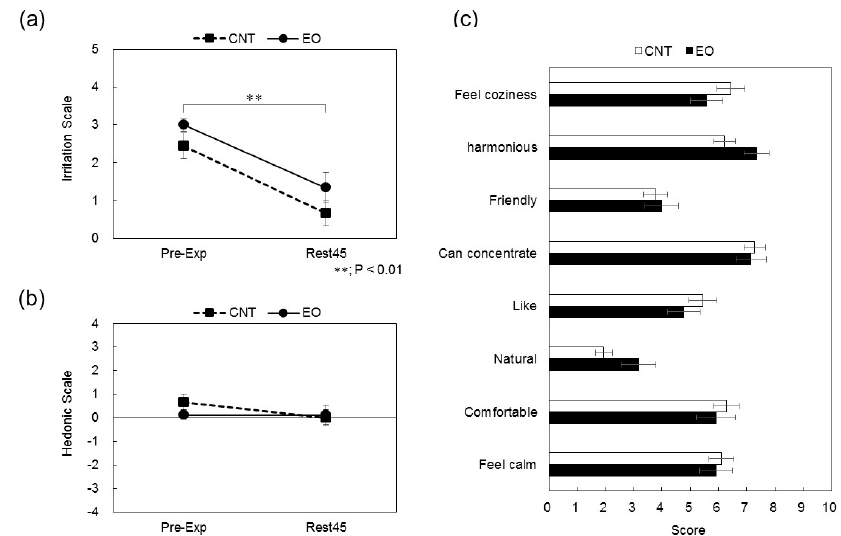
Figure 3. Subjective effects of the odor of the experiment room. ( a ) Irritation scores reported by participants in the control (square) and Japanese cedar wood essential oil (experimental; circle) conditions. CNT indicates the control condition, while EO indicates the experimental condition. Differences in pre-experiment and the end of experiment values were significant in both conditions ( p < 0.01). Data are shown as mean ± SEM; ( b ) Hedonic scores reported by participants in the control (square) and Japanese cedar wood essential oil (circle) conditions. No significant differences between conditions were observed. Data are shown as mean ± SEM; ( c ) Visual analog scale scores reported by participants in the control (white) and Japanese cedar wood essential oil (black) conditions. Differences between conditions were not significant. Data are shown as mean ± SEM.